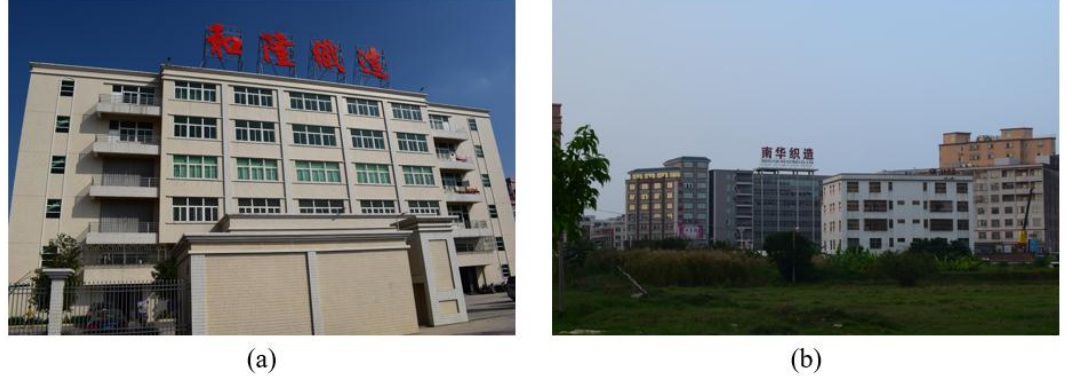
Figure 13. Textile and garment factories in ( a ) Shanbing; and ( b ) Gurao.